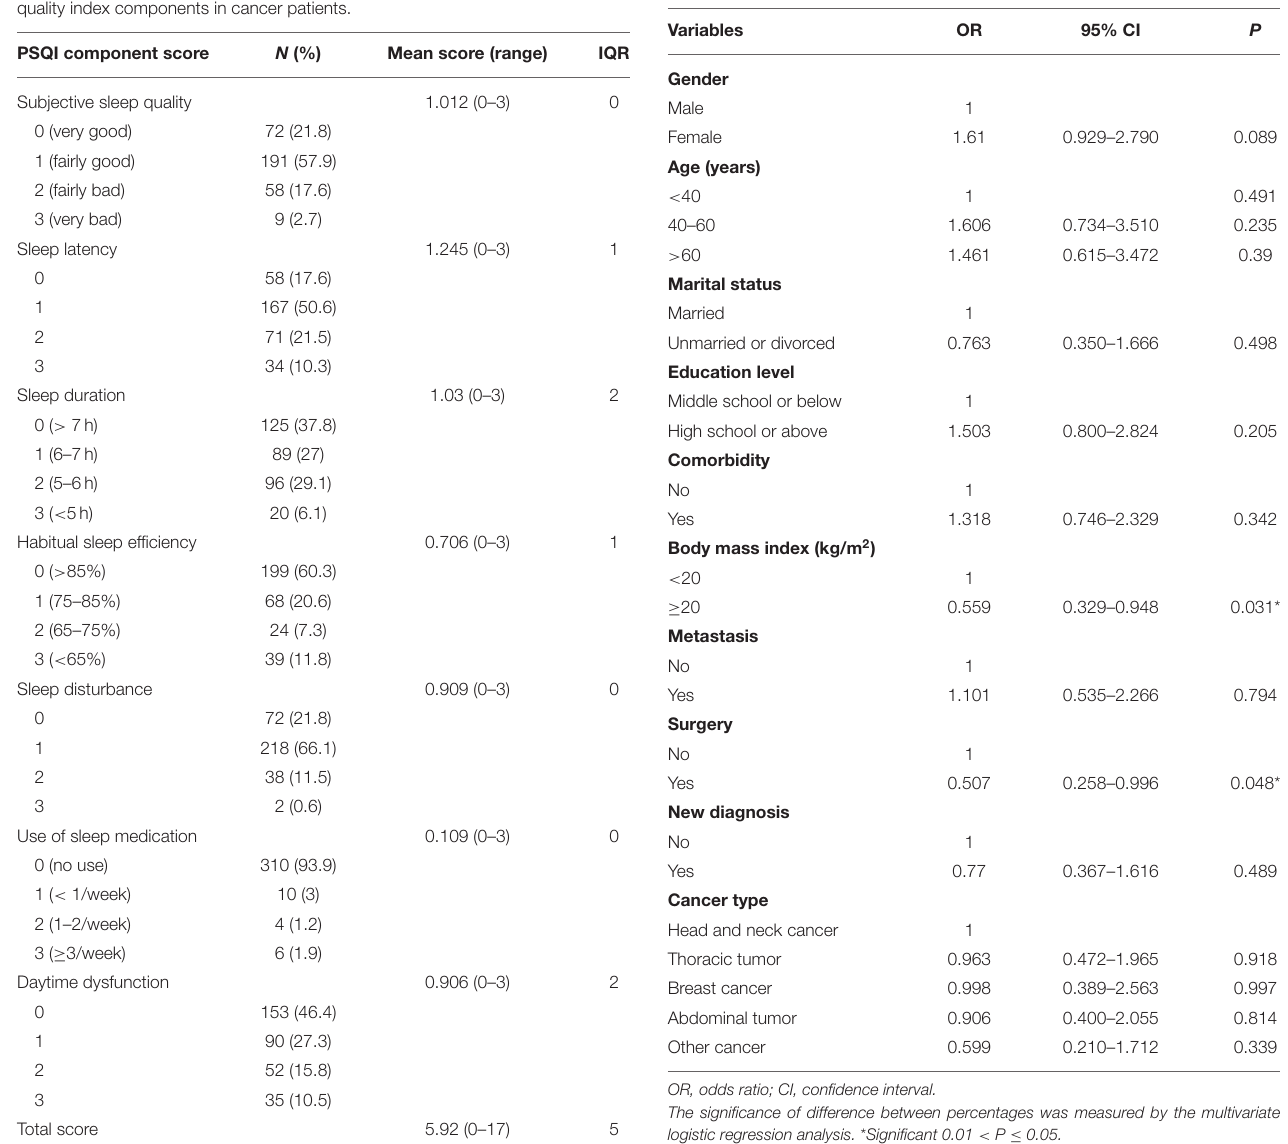
TABLE 3 | Predictors of sleep disturbance in cancer